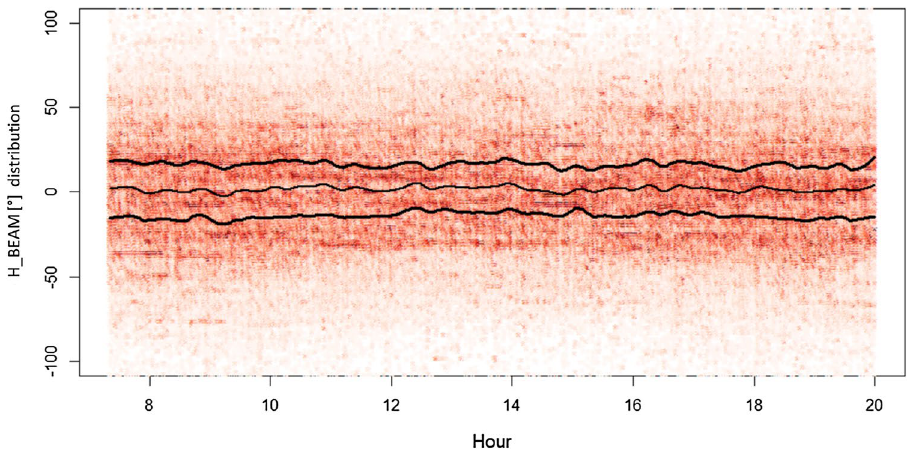
Figure 8. Angular distribution of measures around the direction of maximum power for Sun cells oriented during July 2nd. Lines identify the distribution median (the central line) and +/− standard deviation deviation (color saturation reflects the density of cases).